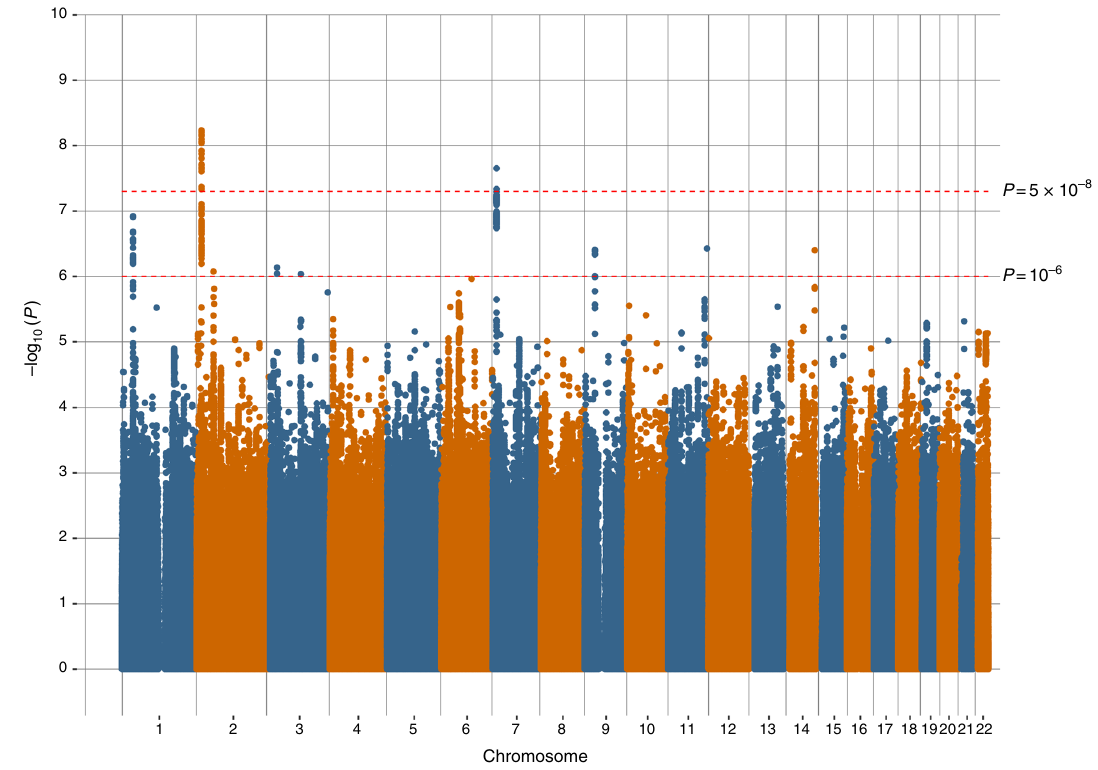
Fig. 2 Manhattan plot of the observed – log 10 P -values of each variant for an association with probable major depressive disorder ( n = 174,519) in the UK Biobank cohort. Variants are positioned according to the GRCh37